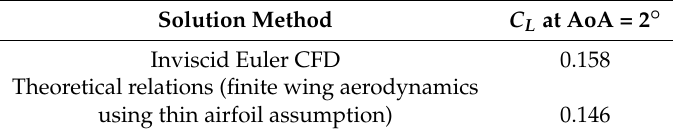
Table A3. Aerodynamic coefficients for the undeformed plate